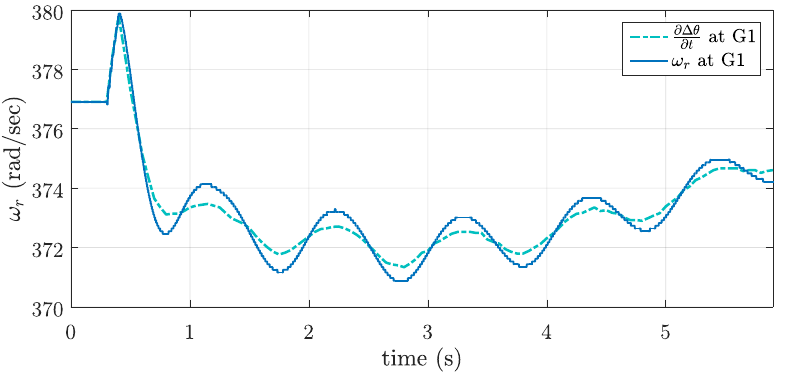
Figure 7. Rotor speed and derivative of the angle bus in